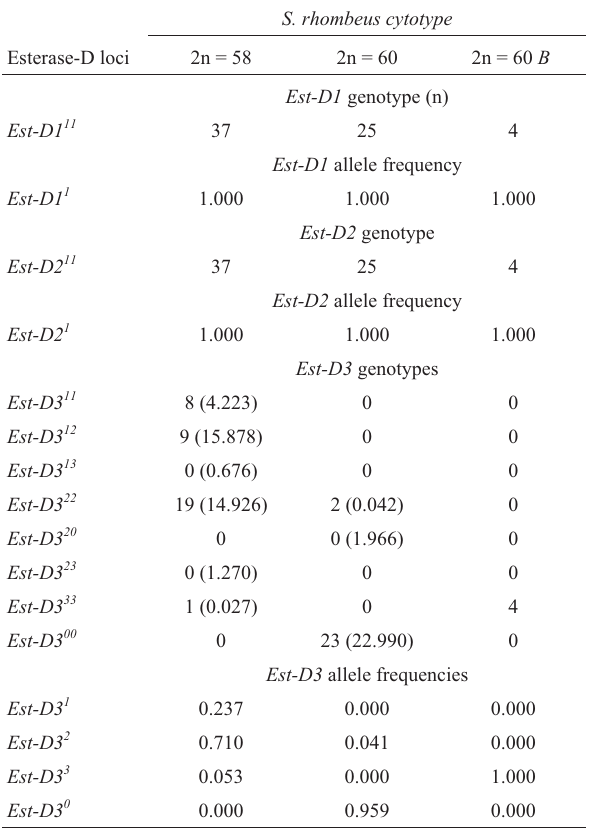
Figure 1 - Location of Lake Catalão in the Brazilian Central Amazon where specimens of the piranha Serrasalmus rhombeus were sampled.